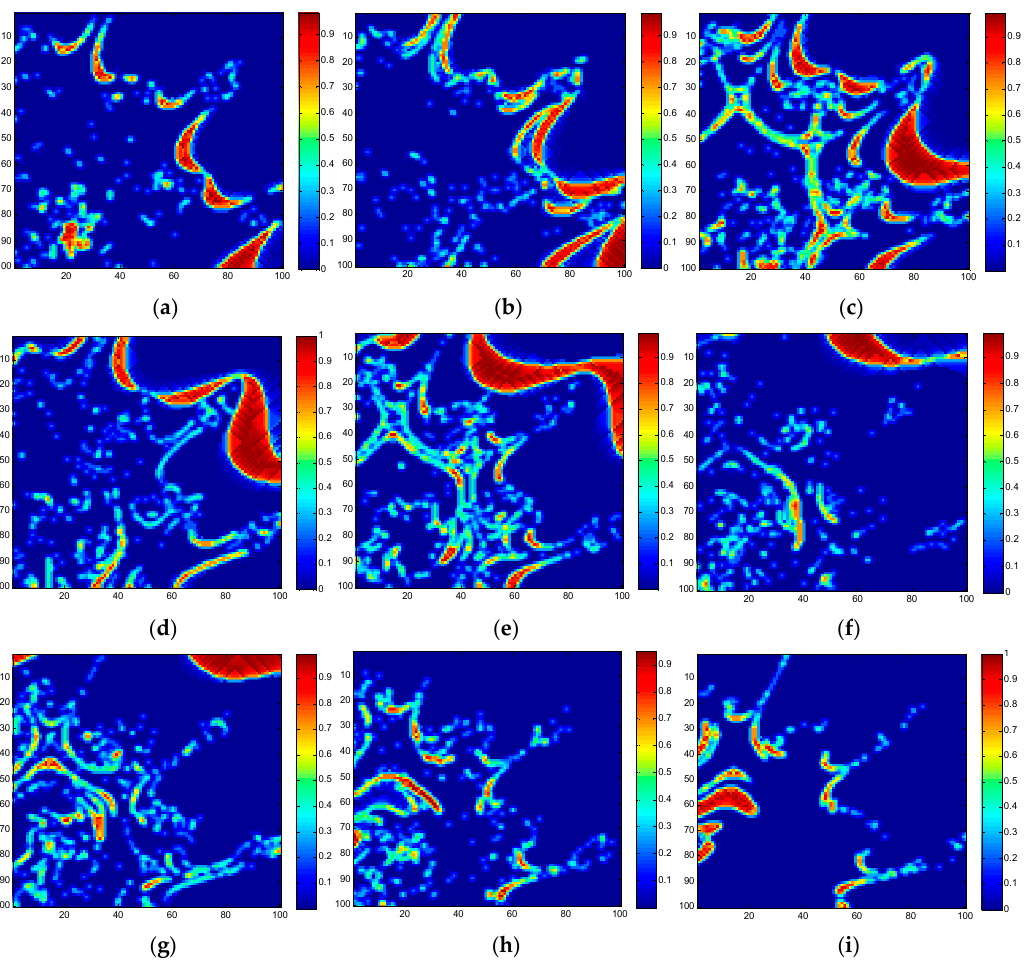
Figure 5. Simulated Data Cube 3 (DC-3). ( a ) Abundance map of #1. ( b ) Abundance map of #2. ( c ) Abundance map of #3. ( d ) Abundance map of #4. ( e ) Abundance map of #5. ( f ) Abundance map of #6. ( g ) Abundance map of #7. ( h ) Abundance map of #8. ( i ) Abundance map of #9.